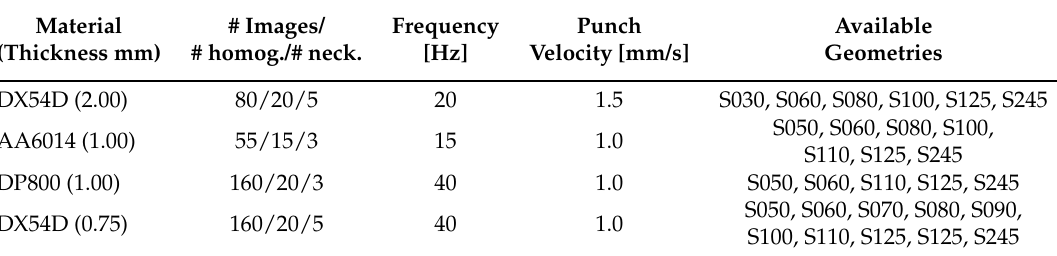
Table 2. Database per material with process